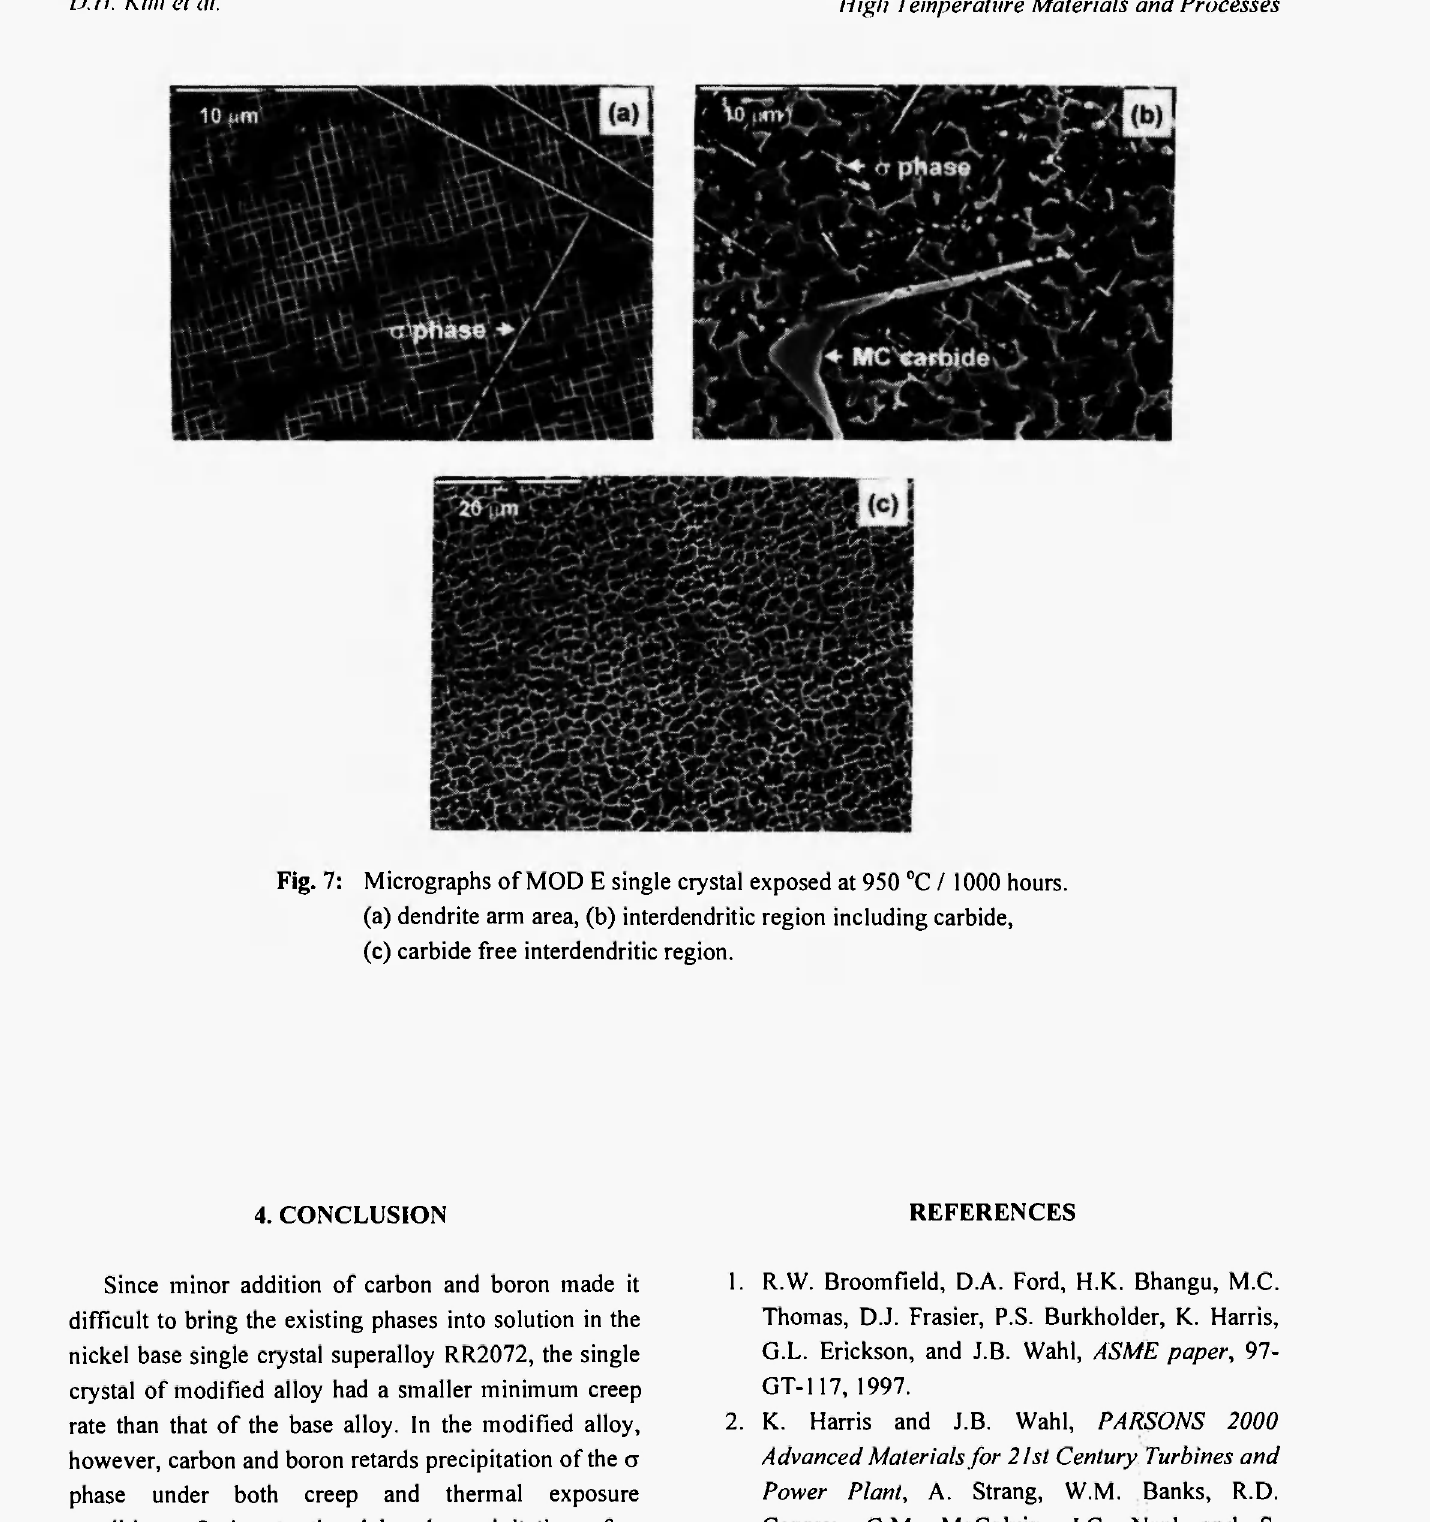
Fig. 7: Micrographs of MOD Ε single crystal exposed at 950 °C / 1000 hours, (a) dendrite arm area, (b) interdendritic region including carbide, (c) carbide free interdendritic